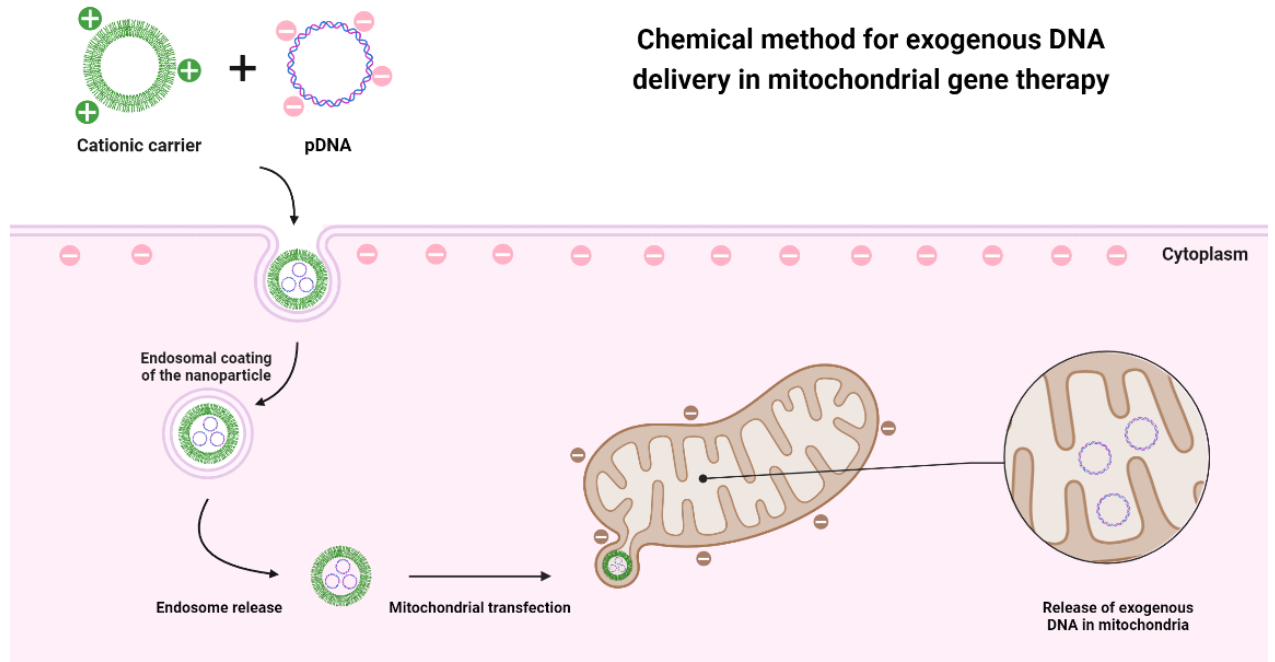
Figure 3. Representative illustration of the application of chemical methods in the delivery of genetic material to the mitochondria, based on the use of a cationic nanotransporter that through electrostatic interactions manages to penetrate both the cell membrane and the mitochondrial membranes.